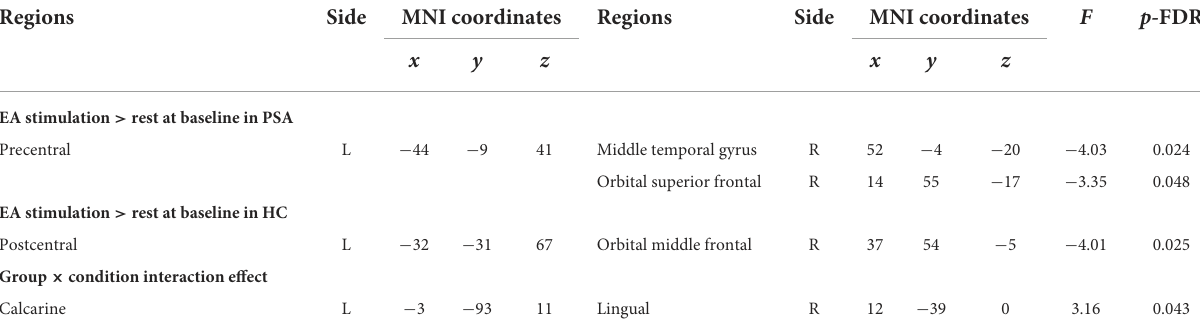
TABLE 3 Significant static FC values during EA stimulation. Regions